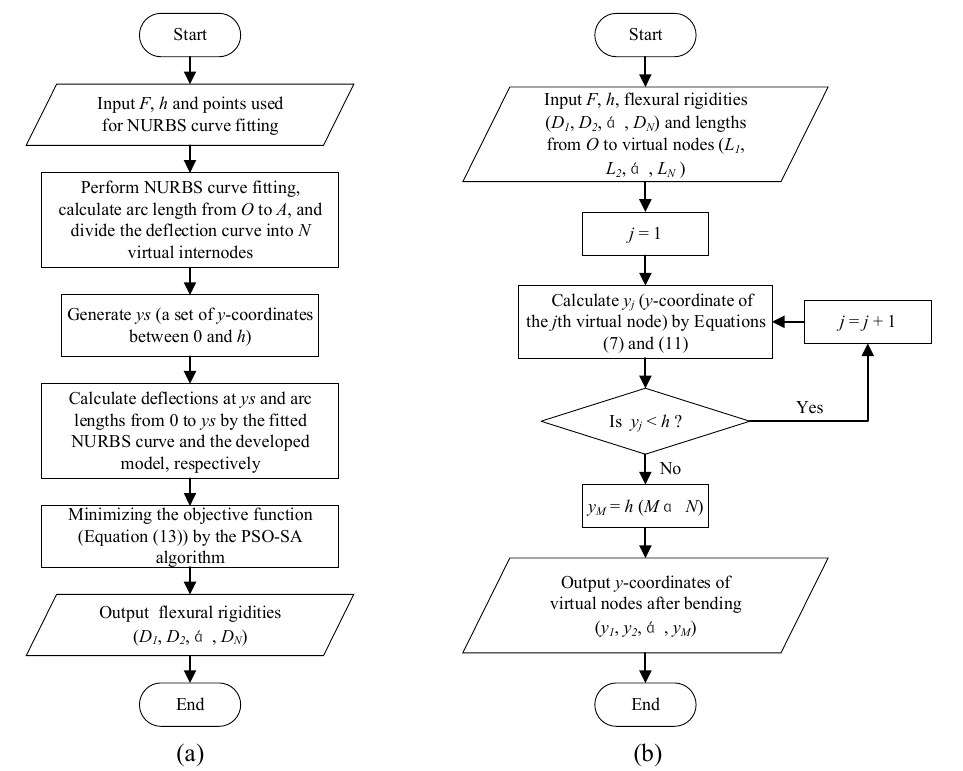
Figure 3. ( a ) The flow chart of calculation for piecewise flexural rigidities. ( b ) The flow chart of calculation for the y -coordinates of virtual nodes after bending.